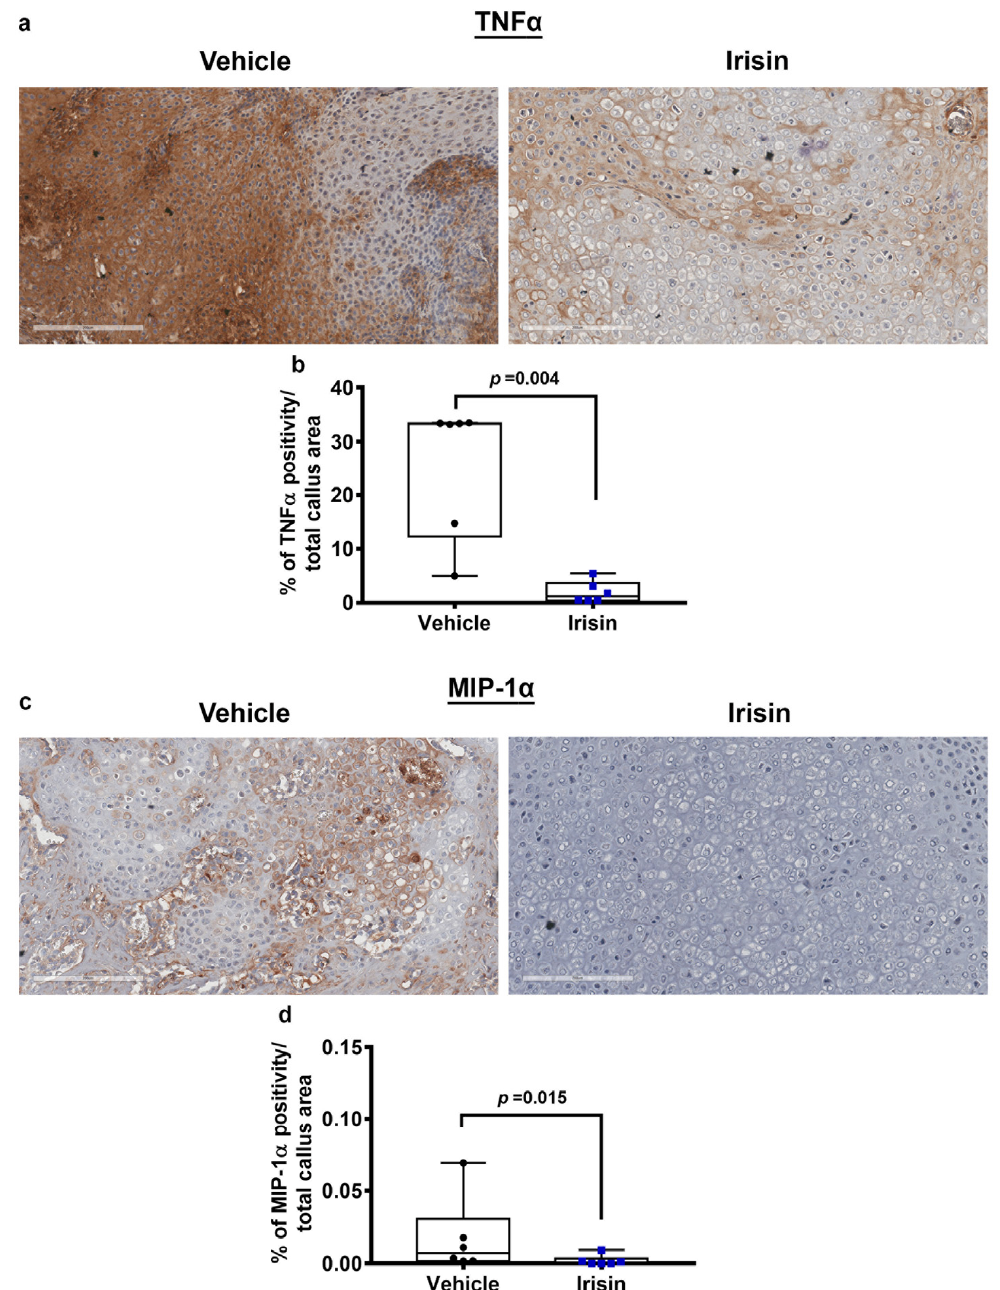
Figure 2. Representative images of ( a ) TNF α and ( c ) MIP-1 α immunostaining on callus section obtained from vehicle-treated mice ( n = 6) and irisin-treated mice ( n = 6) at 10 days after fracture (scale bars 200 µm). Dot plots showing quantification of ( b ) TNF α ( d ) and MIP-1 α expression. Data are shown as dot plots with median, from max to min, with all data points shown. Mann–Whitney test was used to compare groups.